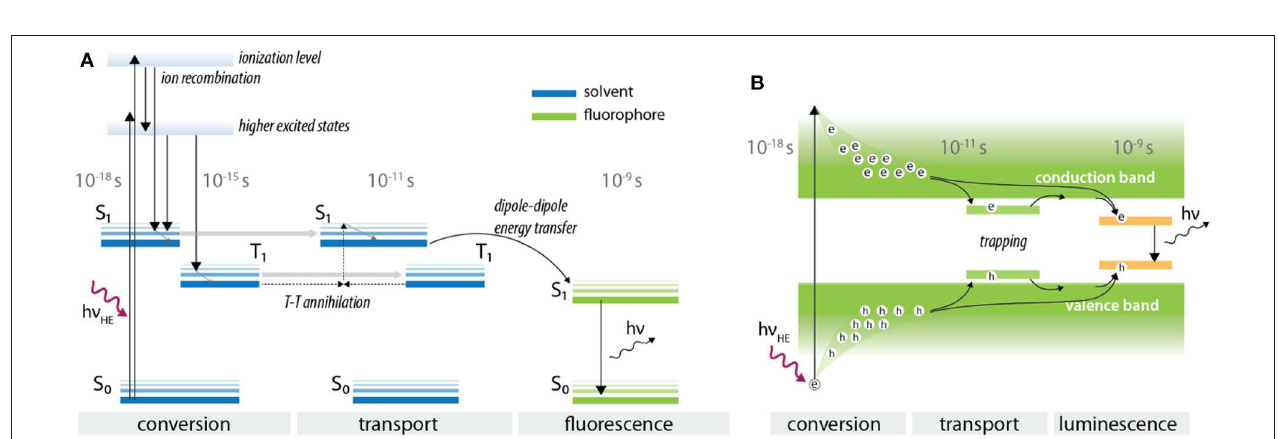
FIGURE 9 | Typical processes of scintillation in (A) organic and (B) inorganic scintillators. The time scales over which these processes occur are also shown, indicating excellent temporal resolution. (B) was adapted from Nikl et al. [89].